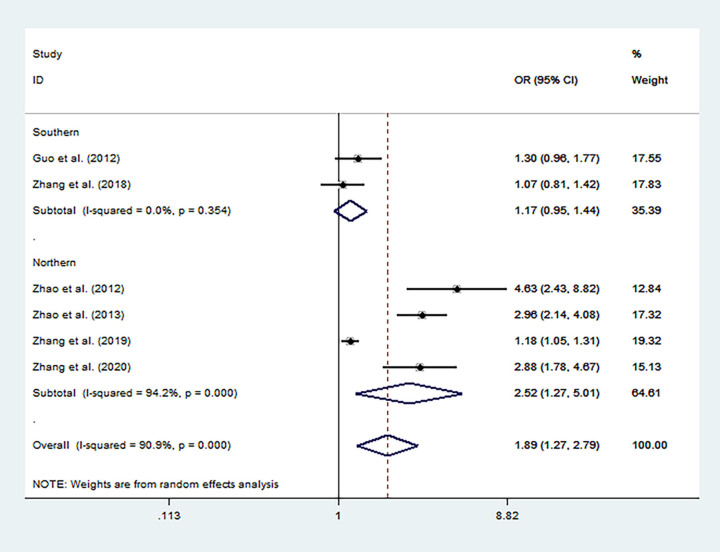
Forest plot for the association between MTHFR C677T polymorphism and autism susceptibility in allele genetic model stratified by region.